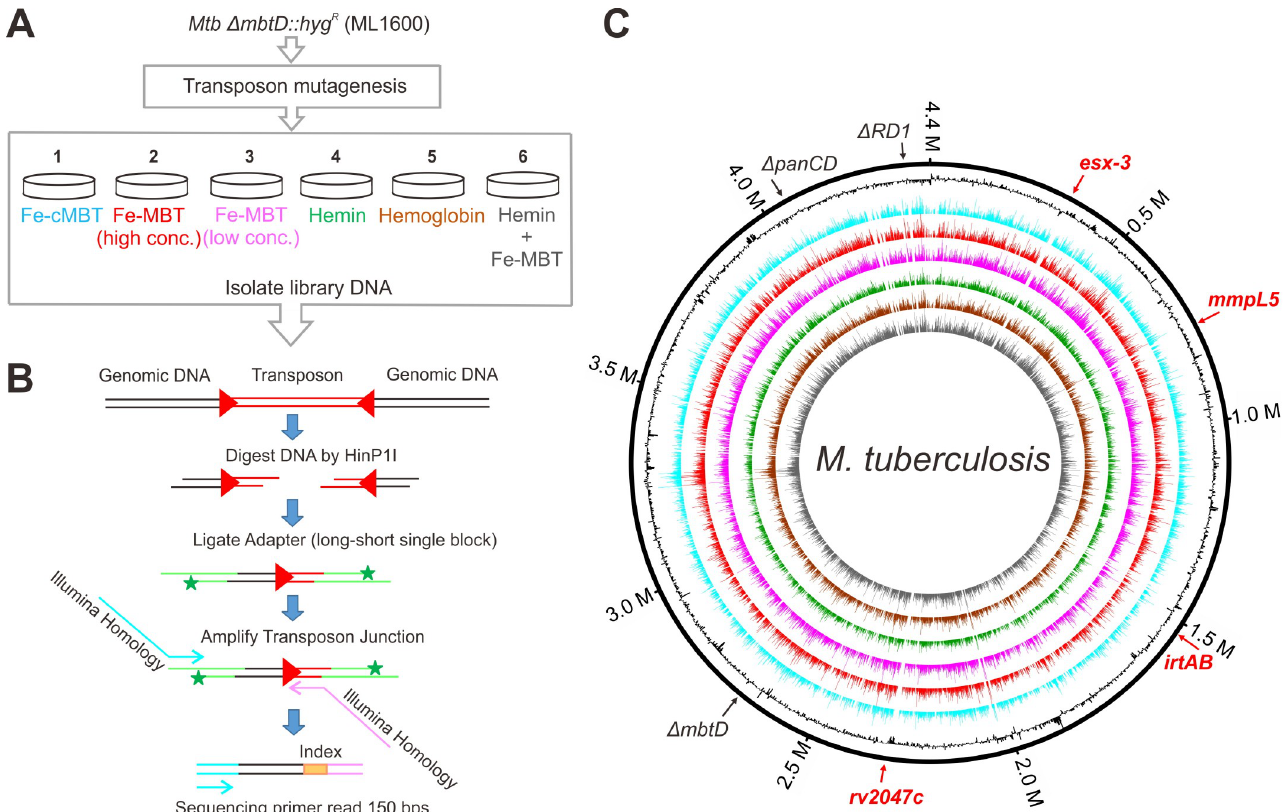
Fig 2. Construction of M . tuberculosis transposon libraries. (A) The Mtb transposon mutagenesis library was generated from the siderophore-deficient mutant ML1600 ( Δ mbtD :: hyg r ). The library was cultured on low iron 7H9/ADS agar plates supplemented with (i) 500 ng/mL Fe-cMBT; (ii) 250 ng/mL Fe-MBT (high concentration); (iii) 50 ng/mL Fe-MBT (low concentration); (iv) 20 μ M hemin; (v) 5 μ M hemoglobin and (vi) 20 μ M hemin plus 250 ng/mL Fe-MBT, respectively. The library DNA was isolated from the plates after three weeks. (B) Library building protocol. Genomic DNA pool was digested by Hin P1I to generate GC-tails, allowing to the ligation of GC-tailed adapters which compose of short 3’ blocked and long oligonucleotides. The 3’ end of the shorter oligo was blocked ( � ) by C6-TFA-amino modification so that it could not be extended during amplification. The transposon-chromosome junctions were selectively amplified using primers (S2 Table) that recognize the end of the transposon and the 5’ end of the long adapter oligo. These primers contain all requisite sequences to permit direct multiplex sequencing of amplicons on an Illumina NextSeq 500 platform. (C) Transposon-chromosome junctions from high density mutant libraries were identified by deep sequencing. The six concentric circles in different colors represent the six libraries corresponding to (A). From the outer to the inner, they are (i) cMBT; (ii) high MBT; (iii) low MBT; (iv) hemin; (v) hemoglobin and (vi) hemin plus high MBT, respectively. The number of normalized sequence reads corresponding to each insertion site is represented as one color bars mapped onto the circular chromosome of M . tuberculosis H37Rv. Black contour represents the GC content of the chromosome (G+C content higher or lower than 50% are represented as contours outside or inside the ring, respectively). The genomic deletion regions such as Δ RD1, Δ panCD and Δ mbtD are indicated in black. The genomic regions such as esx-3 , irtA/B , mmpL5 and rv2047c are indicated in red. Nucleotide positions are indicated (million bases). Plots were generated using Circos 0.69–5